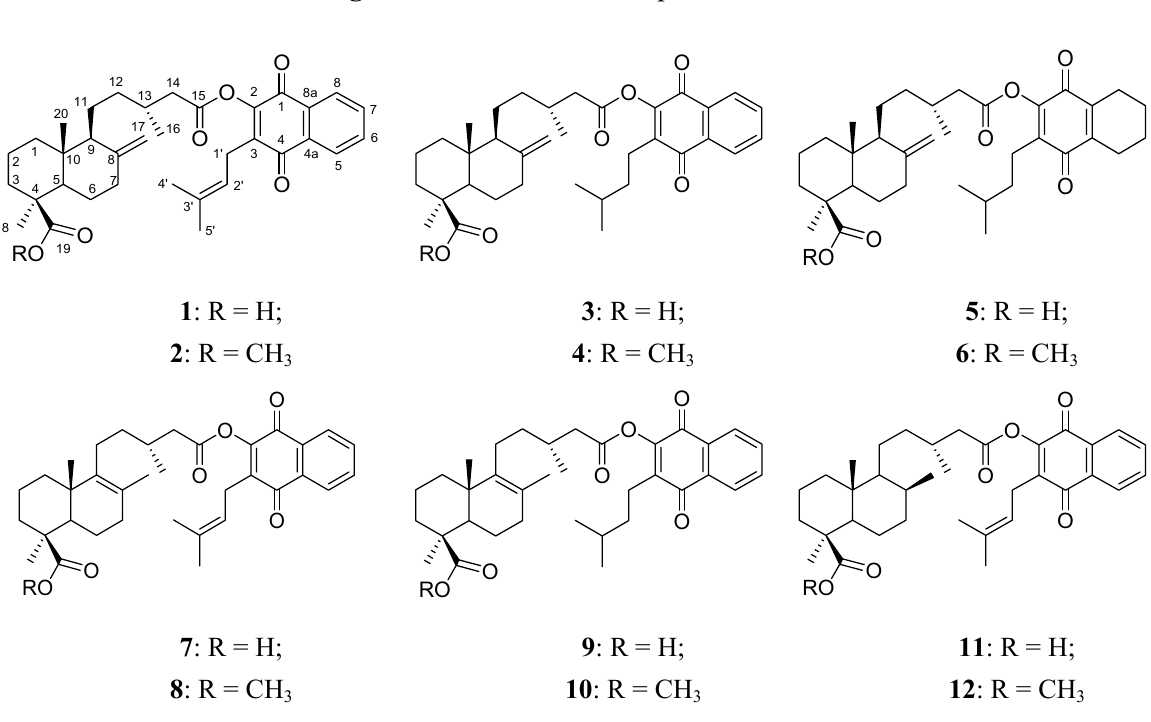
Figure 1. Structures of compounds 1–12